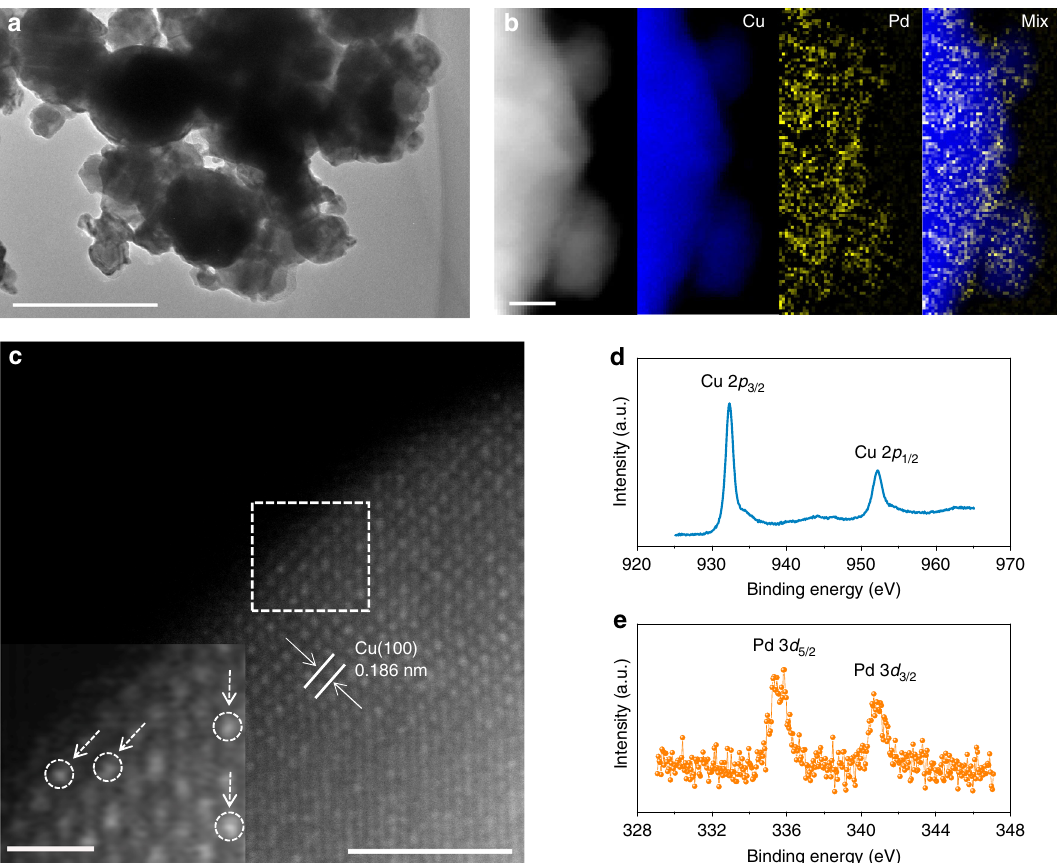
Fig. 2 Characterization of Pd-doped Cu (CuPd 0.007 ) electrocatalysts. a TEM image of Pd-doped Cu catalysts. Scale bar is 200 nm. b High-resolution EELS mapping. Scale bar is 5 nm. c HAADF-STEM image and the inverse fast Fourier transition pattern (inset) of selected area. Scale bars are 2 nm for ( c ) and 1/ 2 nm for the inset, respectively. d , e X-ray photoelectron spectra of Cu 2p ( d ) and Pd 3d ( e ). All measurements were performed using a Pd-doped Cu electrocatalyst after COR at − 0.62 V vs. RHE in 1 M